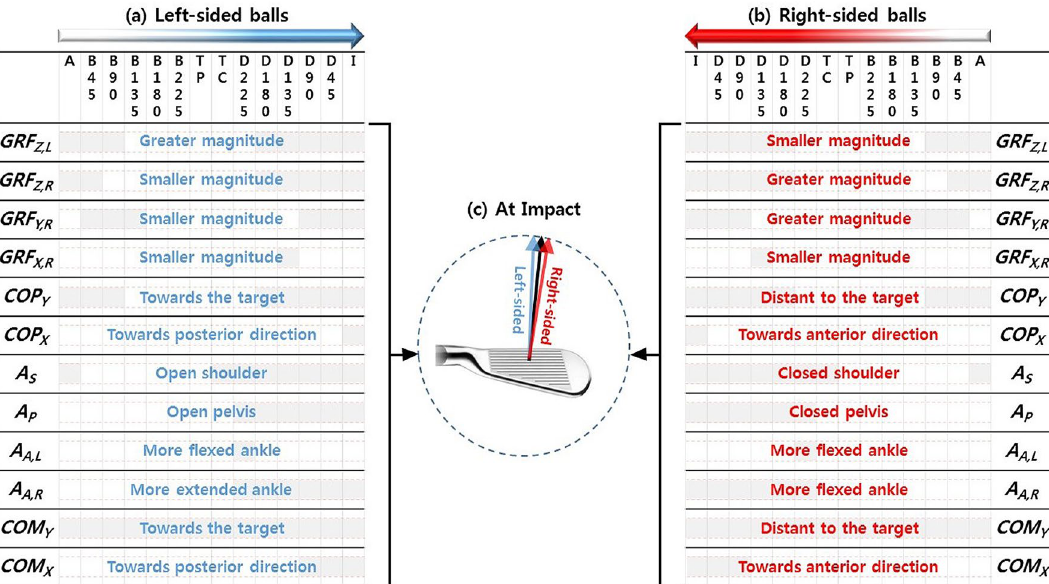
Figure 4. Summary of changes in golf swing due to changes in ball position for GRF variables, body segment and joint angles, and whole-body actions. These variables that showed statistical significance in SPM are shown in (a,b) . (a) Changes in kinematic and kinetic variables in the left-sided ball positions across swing events from address (A) to impact (I), (b) changes in kinematic and kinetic variables in the right-sided ball positions, and (c) club path at impact (refers to Kim et al.’s previous study). The general trends are described in (a,b) . The grey areas show the parts with statistical significance (p < .01). GRF Z,L left foot vertical GRF, GRF Z,R right foot vertical GRF, GRF Y,R right foot mediolateral GRF, GRF X,R right foot anteroposterior GRF, COP Y mediolateral centre of pressure, COP X anteroposterior centre of pressure, A S shoulder angle, A P pelvis angle, A A,L left ankle angle, A A.R right ankle angle, COM Y mediolateral centre of mass, COM X anteroposterior centre of